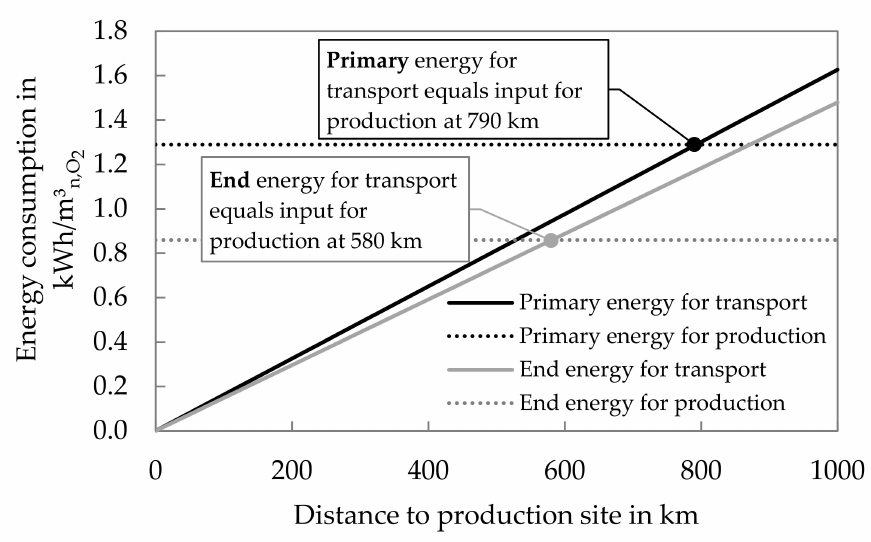
Figure 6. Comparison of energy consumption for transport and production of liquid O 2 .